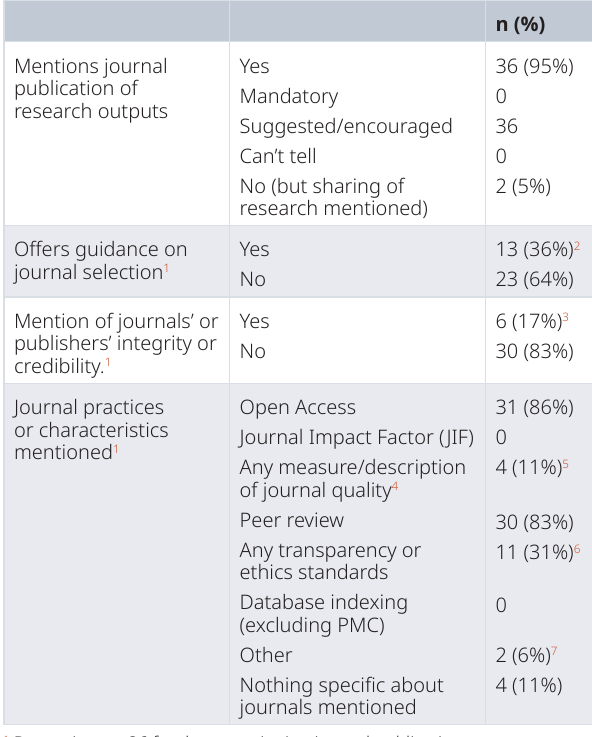
Table 4. Funder position and information provided about journal publication of funded research